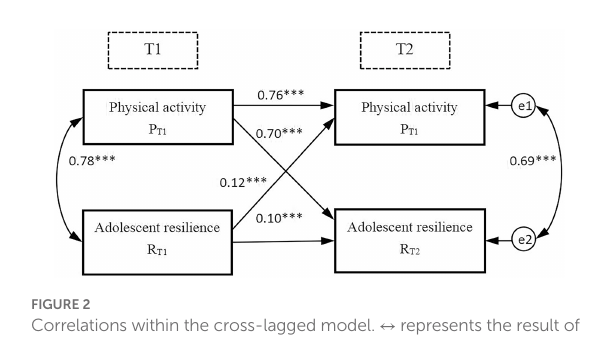
FIGURE 2 Correlations within the cross-lagged model. ↔ represents the result of the correlation analysis, → represents the result of the regression analysis; the numbers represent the correlation coefficient and unstandardized regression coefficients of the path; in the route of the regression analysis, the solid lines ( ↔ or → ) indicate that the regression coefficient is significant, *** p <